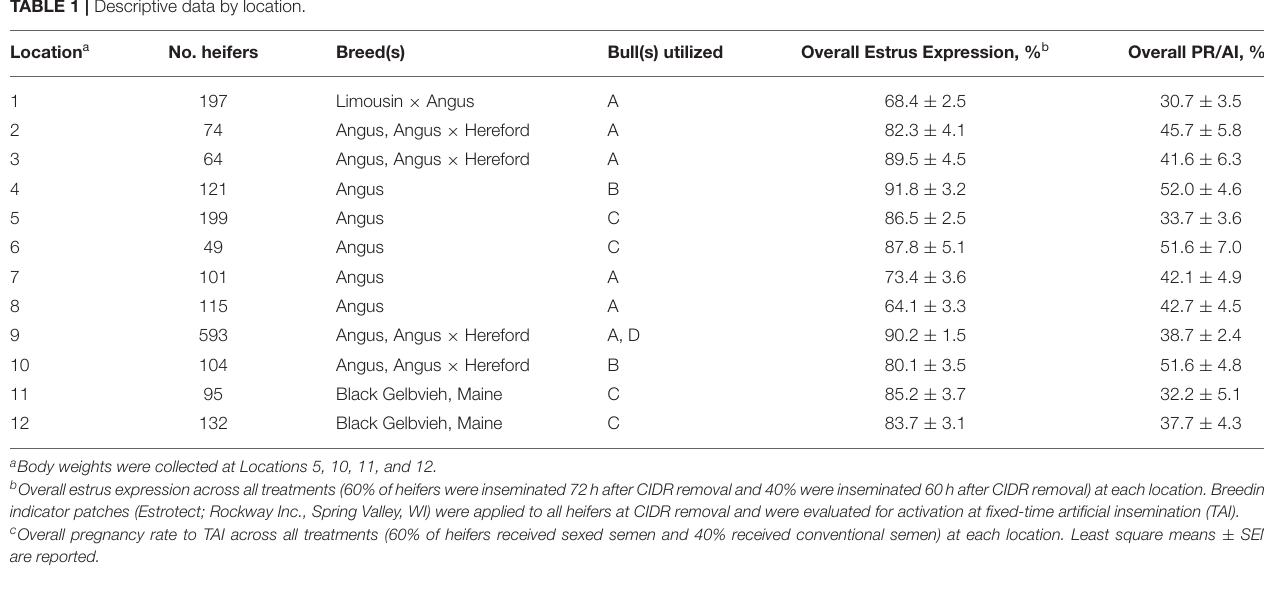
TABLE 1 | Descriptive data by location.